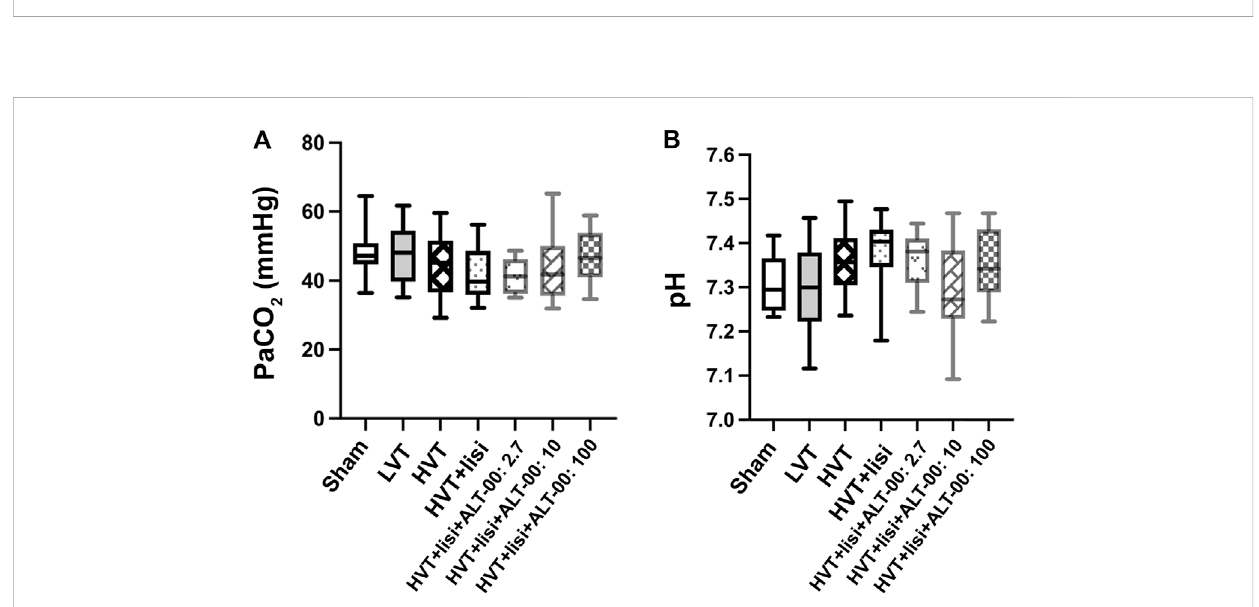
FIGURE 2 Acid base parameters. (A) The arterial partial pressure of carbon dioxide (PaCO 2 ) and (B) the arterial pH were well maintained after 4 h without differences between the groups or the sham group at baseline, which indicated that tidal volume, respiratory rate and inspired CO 2 were properly adjusted to maintain normocapnia; n = 14/group, baseline valuesare shown for theshamgroup, values after 4 hof ventilation for all othergroups,tested by one-way analysis of variance with Tukey